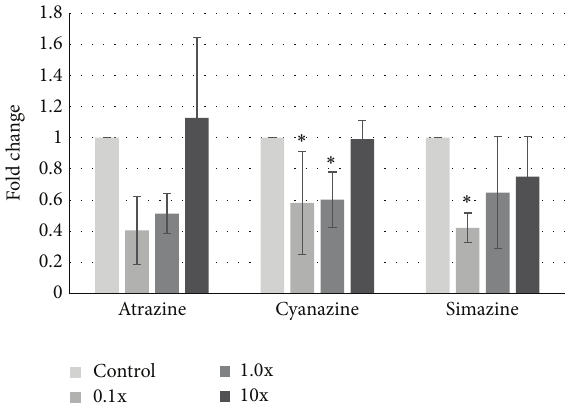
Figure 4: Change in GPR30 expression in MCF-10A cells after atrazine exposure. MCF-10A noncancerous breast cells were treated with 0.1- to 10-fold concentrations of the EPA safe levels of atrazine, cyanazine, or simazine for 24 hours. mRNA was harvested, cDNA was synthesized, and specific amplicons were prepared using primers to GAPDH (reference gene) or GPR30. Resulting fold changes in expression ± standard deviation are shown, with the vehicle control set at 1. Statistically significant changes in induction compared to the control are indicated ( ∗ 𝑝 < 0.05